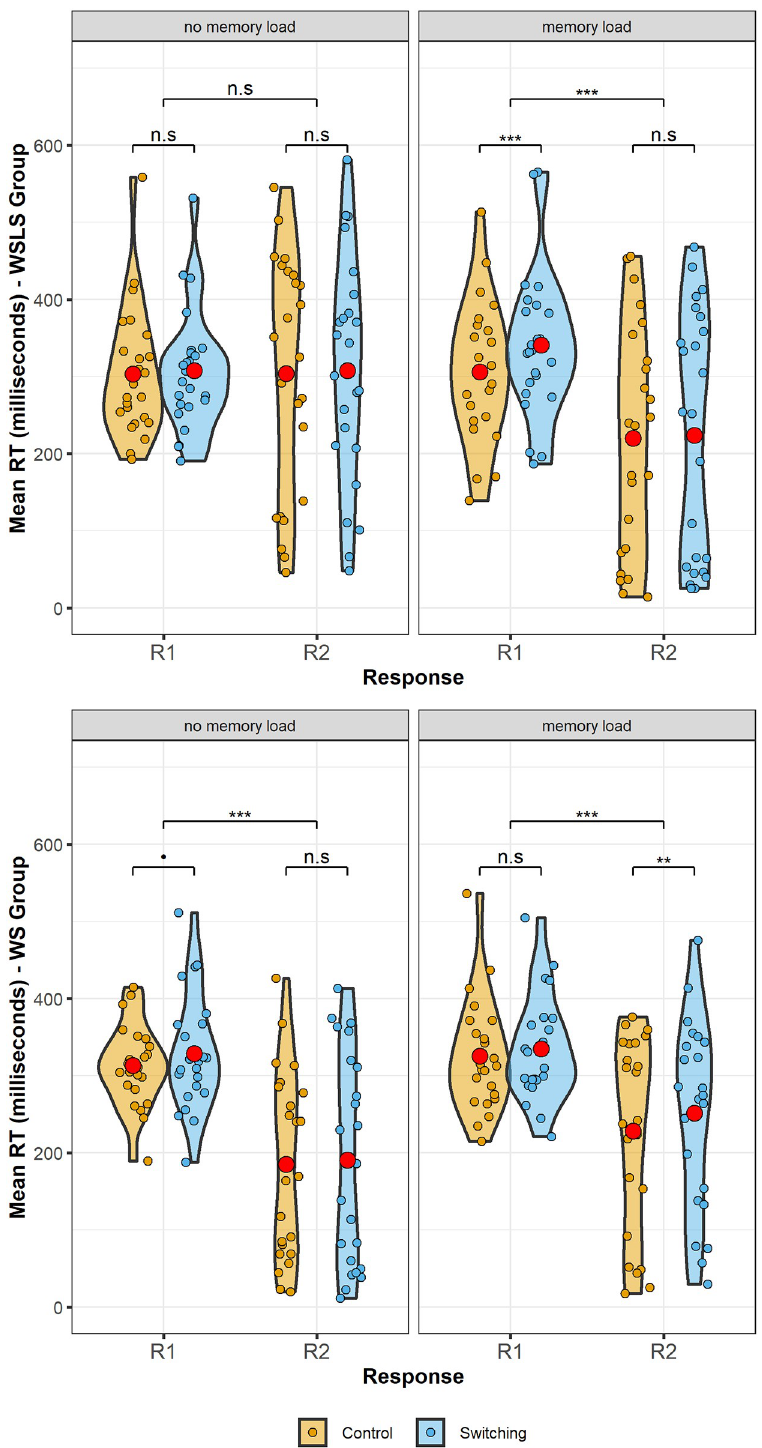
Fig 6. Reaction times at R1 and R2 for the WSLS group (top) and WS group (bottom), split by block condition and memory load.